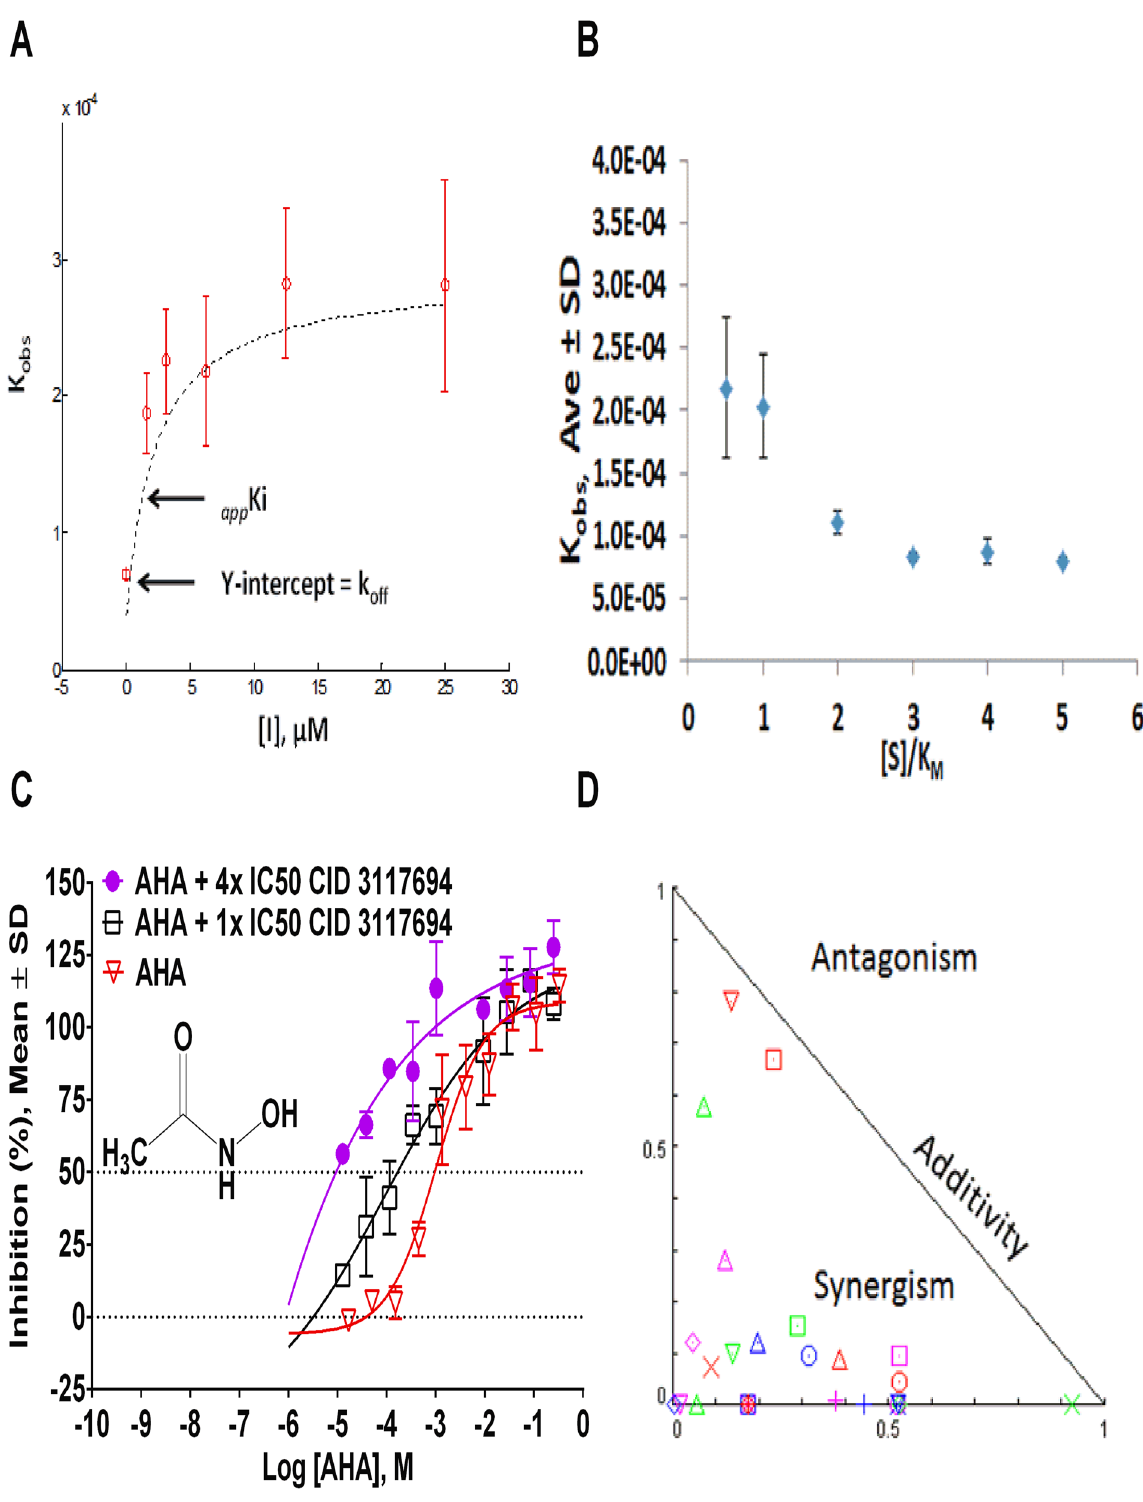
Figure 4. Mechanism of CID 3117694 inhibition of ADAM10. ( A ) Plot of K obs versus [I] for CID 3117694 inhibition of ADAM10. Please note the hyperbolic relationship between k obs and [I] suggesting that inhibitor binding complies with the two-step model. ( B ) Plot of K obs versus [S]/K M for CID 3117694 inhibition of ADAM10. Please note k obs decreases with increase of [S]/K M suggesting that inhibitor competes with a substrate. ( C ) Dose response study of ADAM10 inhibition by AHA alone and in the presence of varying dose of CID 3117694. Please note that AHA IC 50 decreases significantly in the presence of CID 3117694. ( D ) Normalized isobologram of two drug combination effect on ADAM10 activity. Please note that majority of AHA-CID 3117694 combinations produced synergistic effect as compared to a single drug